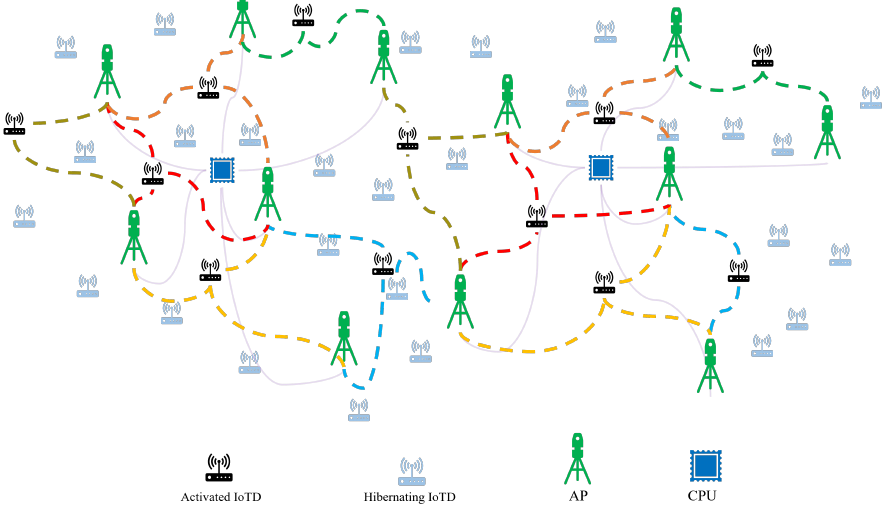
Figure 1. Distributed cell-free massive MIMO system in the Industrial Internet.